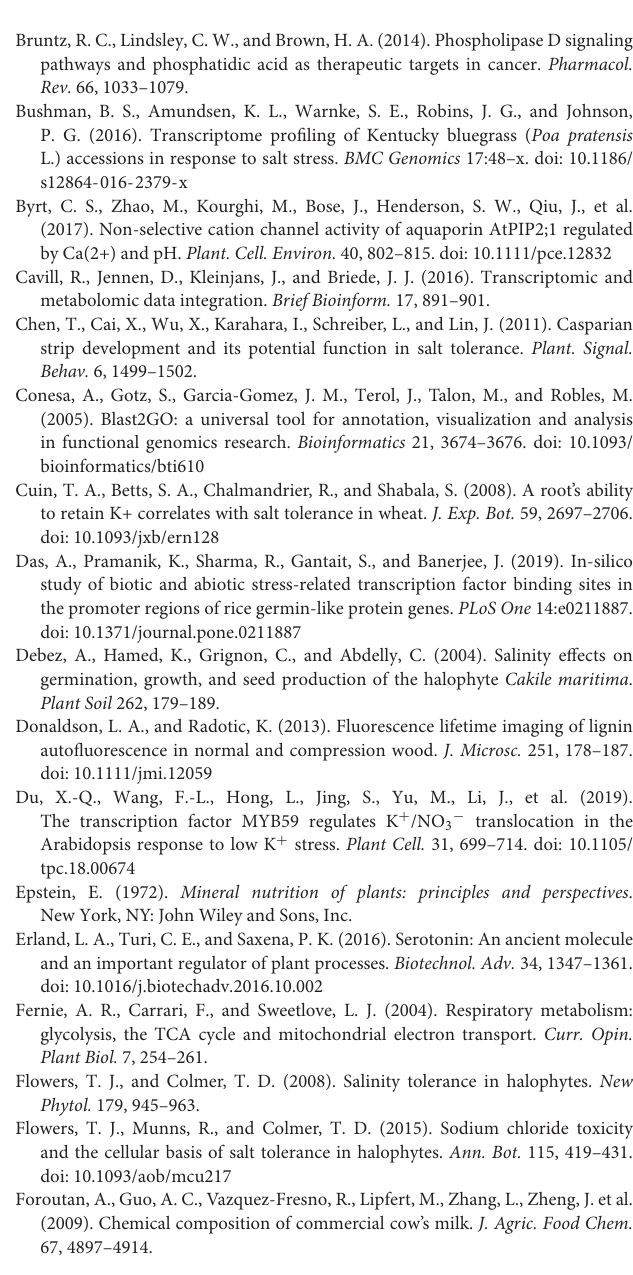
Supplementary Figure 1 | Functional distribution of GO annotation. Supplementary Figure 2 | Proline and dopamine biosynthesis pathways identified in P. nuttalliana. Supplementary Table 1 | Clean reads quality metrics. Supplementary Table 2 | Primer list used for qRT-PCR valiodation of RNAseq data in Puccinellia nuttalliana to salt stress. Supplementary Table 3 | Quality metrics of